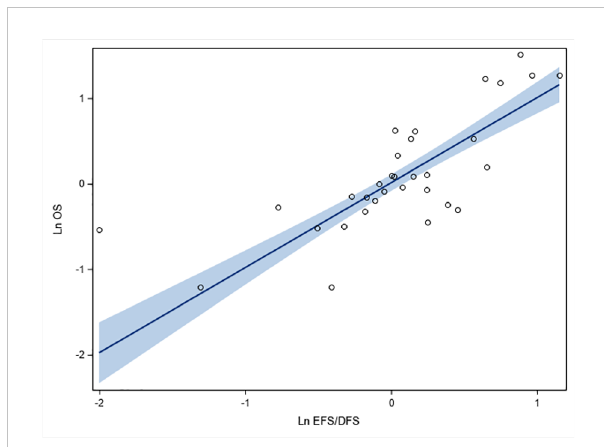
FIGURE 2 Fit plots and fi t statistics for correlation between log HR for OS and log HR for EFS/DFS. Each individual circle of the graph represents HR data point from a single study. Solid blue line indicates the fi tted weighted linear regression line. DFS, disease-free survival; EFS, event-free survival; Ln, natural logarithm; OS, overall